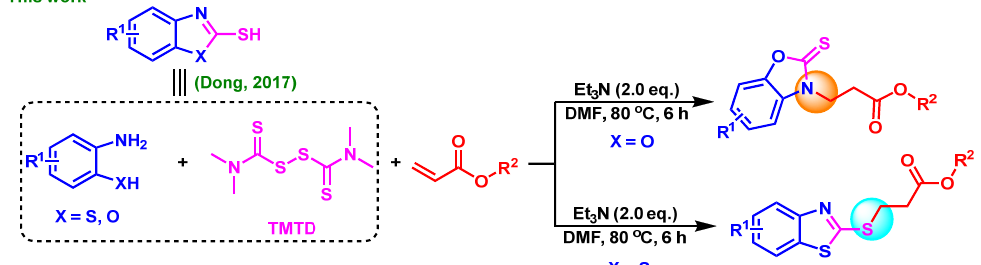
Table 1. Optimization of the reaction conditions a,b